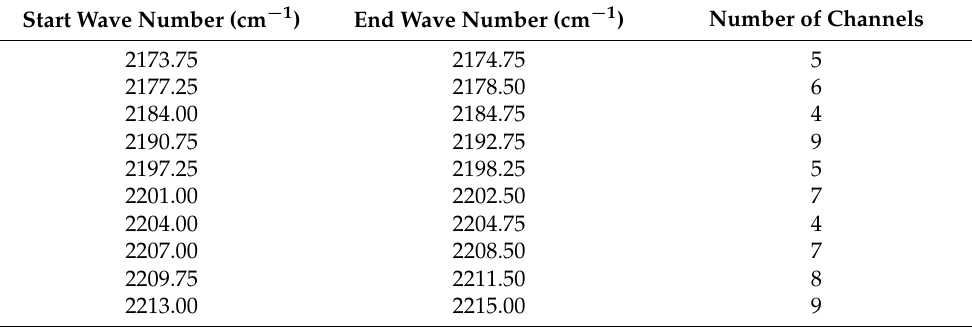
Table 4. List of micro-windows for the NOPIR